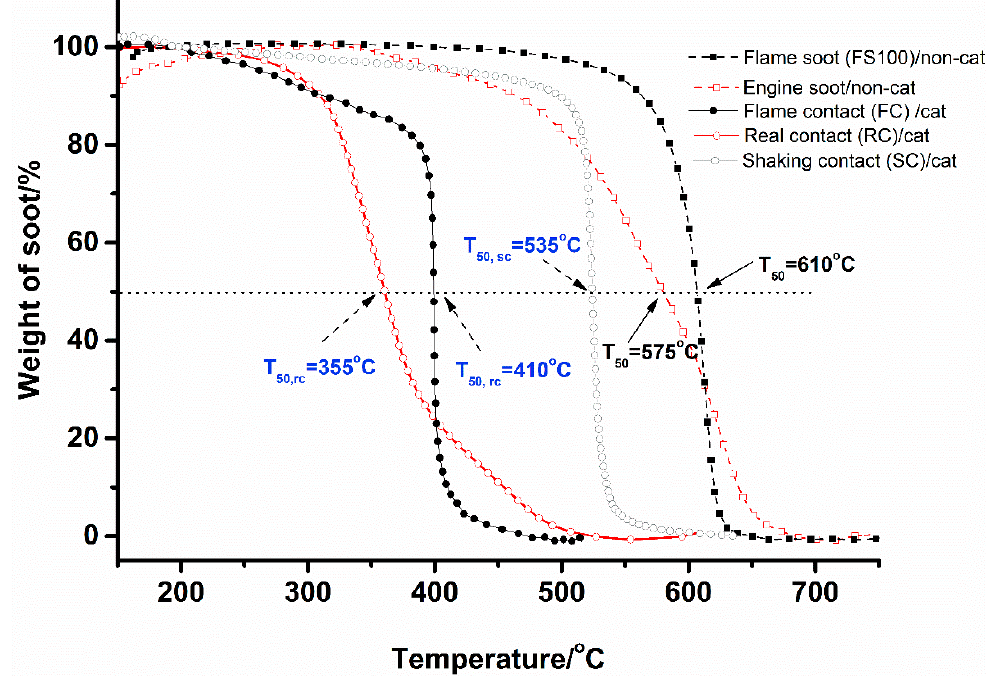
Figure 11. TPO curves for real engine soot: catalytic oxidation under real contact (RC) vs. non-catalytic soot oxidation, flame soot (FS100): catalytic oxidation under flame deposition contact (FC) vs. non-catalytic soot oxidation; and catalytic soot oxidation under “gently-shaking” contact (SC).